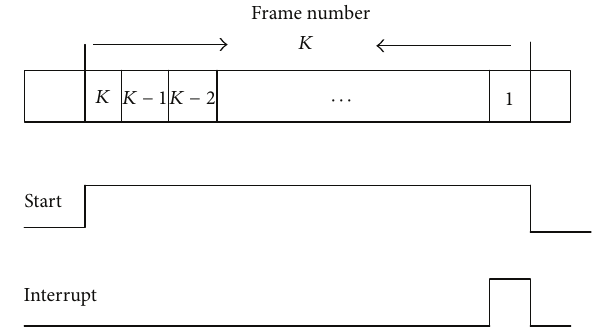
and external source. The internal sources are the three independent sleep timers and the DSP. The external sources are the chip pins, the 3G, and the LTE. For the 3G and the Figure 4: The GSM sleep timer. sleep mode state. The flexible wake-up relationship among the three subsystems is given in Figure